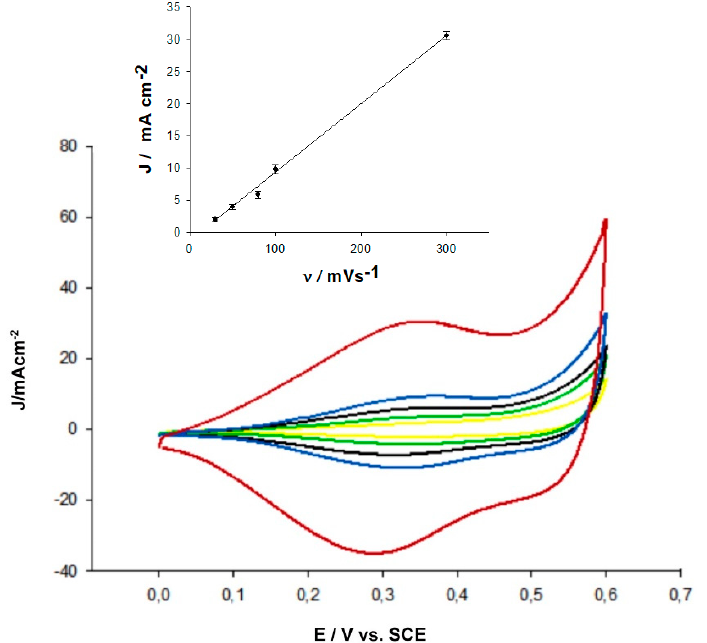
Figure 4. Cyclic voltammograms obtained with a FcSH/h-PG/Au microneedles electrode at different scan rates: 30 mVs − 1 (yellow); 50 mVs − 1 (green); 80 mVs − 1 (black); 100 mVs − 1 (blue); and 300 mVs − 1 (red) in 50 mM PBS at pH 7.5. In the inset: the dependence of J on v relative to the different curves.